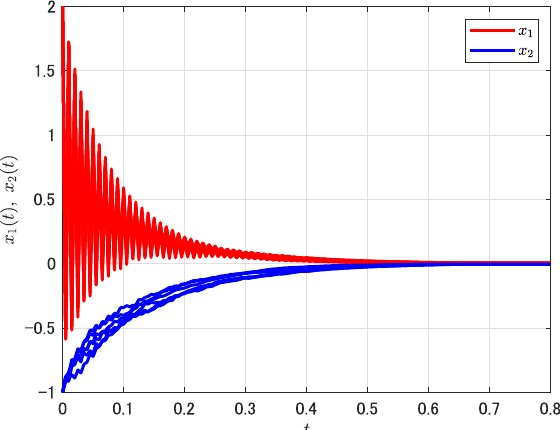
Figure 3. State trajectories of the boost converter under SW